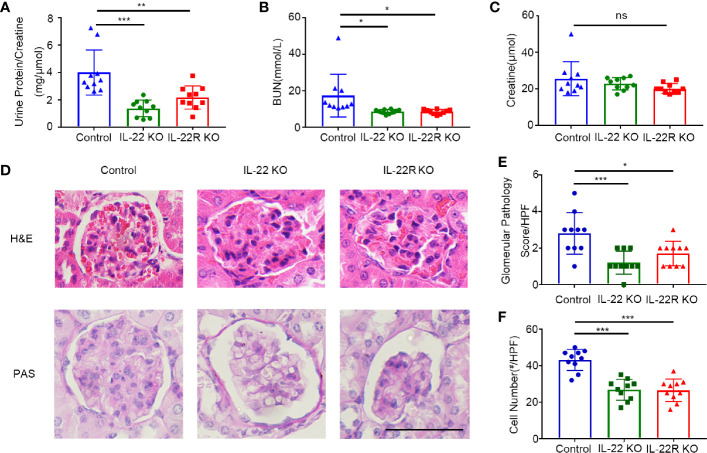
IL-22 or IL-22R deficiency ameliorated renal injury in lupus-prone mice. Renal function as (A) urine protein/creatinine ratio, (B) serum BUN, (C) serum creatinine of 24-weeks-old control and IL-22 KO, IL-22R KO mice. (D) Representative images of kidney biopsies stained in H&E and PAS from control, IL-22 KO, and IL-22R KO mice (24 weeks, scale bar, 50 μm). The glomerular pathology score (E) and cell numbers per glomerulus (F) were analyzed and counted in the PAS stained slides from 24-weeks-old control, IL-22 KO and IL-22R KO mice. Data were expressed as mean ± SD, and are representative of three independent experiments. One way ANOVA was used for comparison among all groups (*P < 0.05, **P < 0.01, ***P < 0.001).